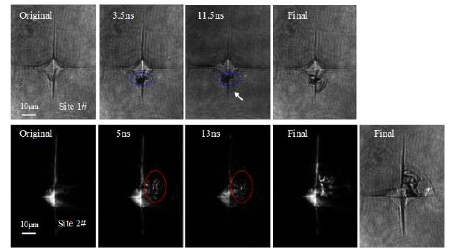
Fig. 5. Dynamics of the cracks expanding under laser irradiation.